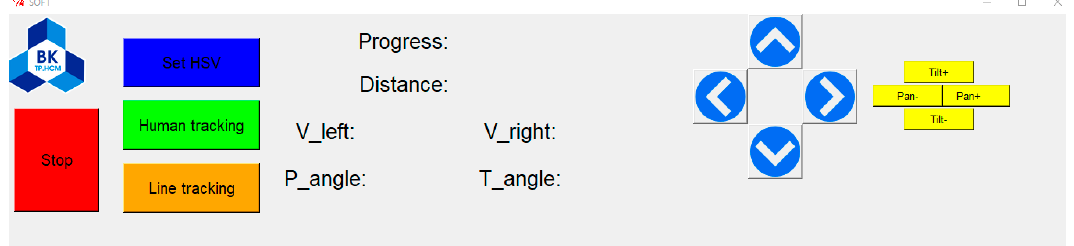
Figure 14. Experimental image that students obtained from digital cameras.